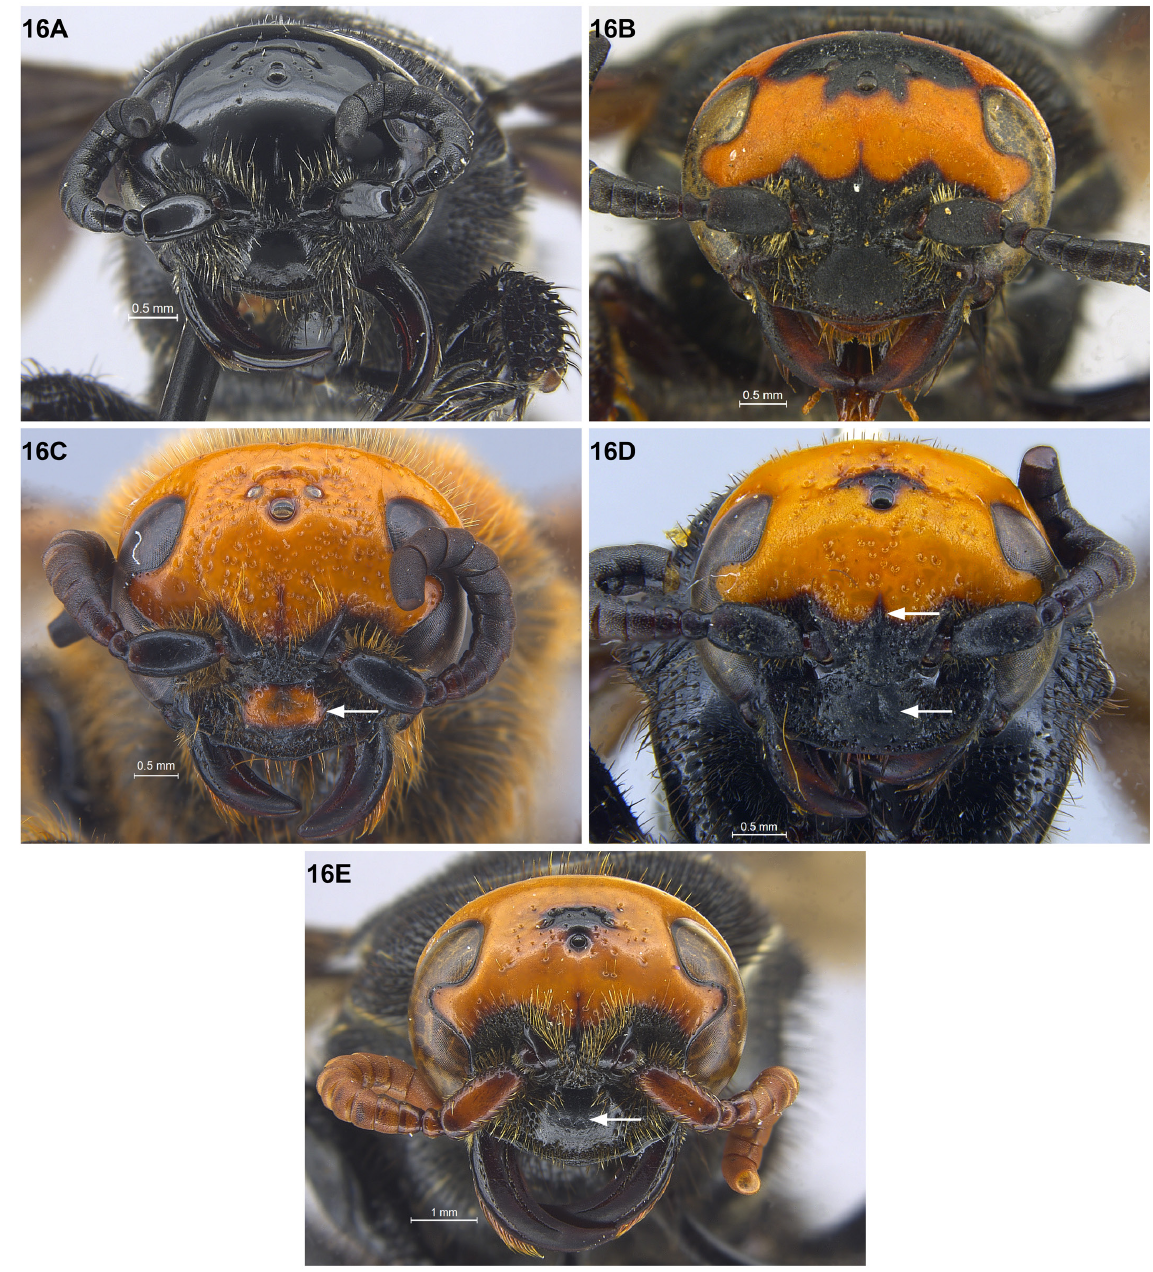
Fig. 16. Females, face. A . Scolia binotata Fabricius, 1804 . B . Sc. binotata orange var. C . Sc. clypeata pseudovollenhoveni Betrem, 1933. D . Sc. pakshaoensis sp. nov., holotype (CAS). E . Sc. superciliaris de Saussure & Sichel, 1864